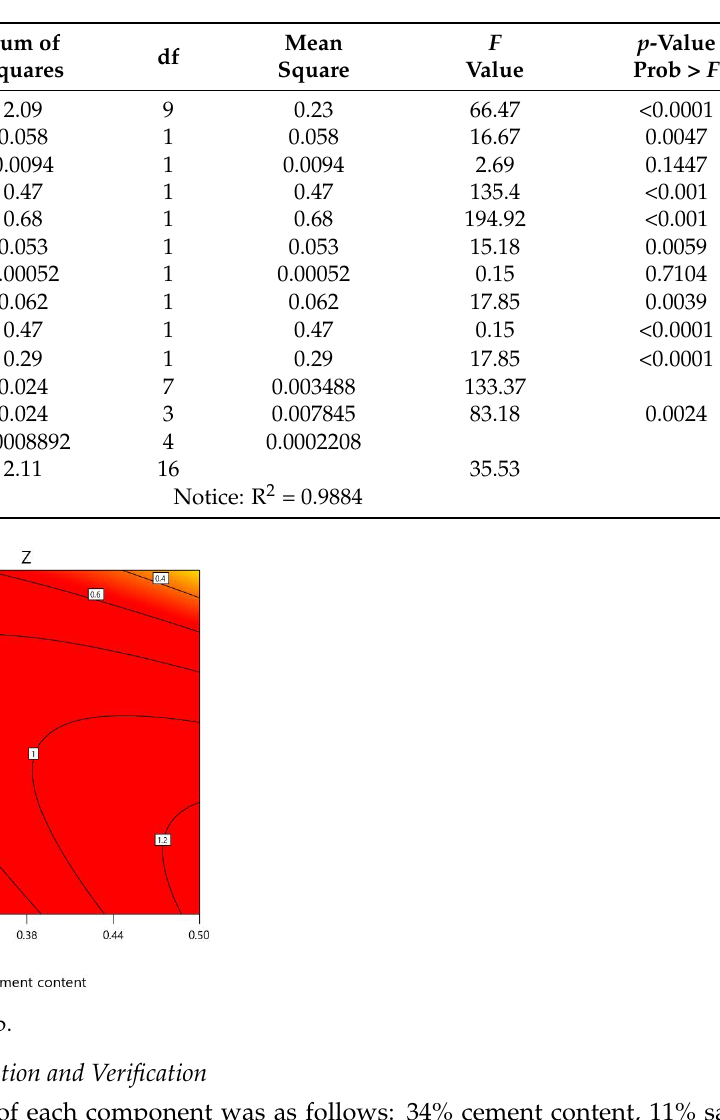
Figure 9. Response surface diagram.